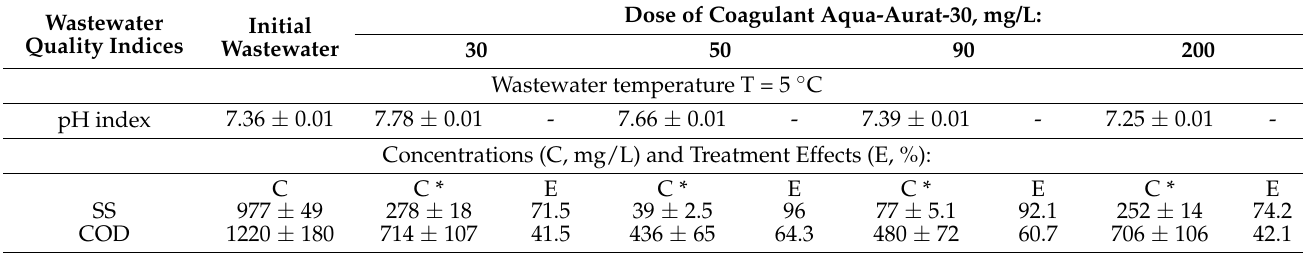
Table 3. The initial wastewater parameters and the course and results of the laboratory studies. Wastewater Quality Indices